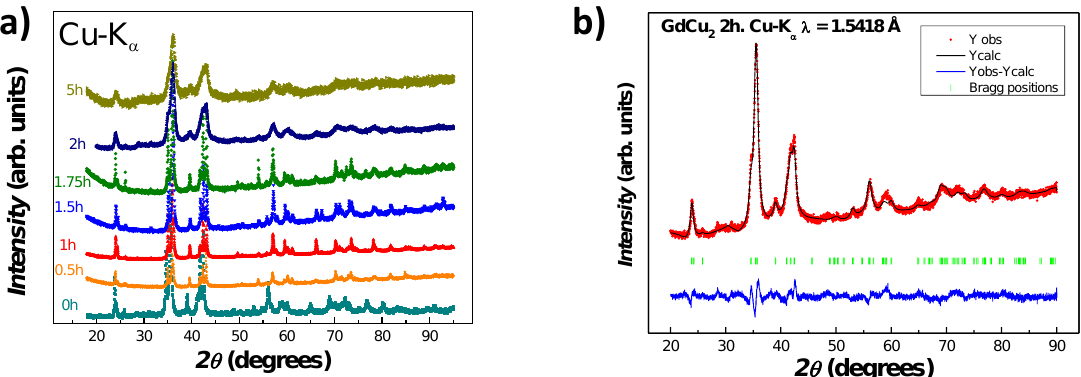
Figure 1. ( a ) XRD profile for GdCu 2 samples. Patterns with increasing milling time have been shifted up and re-scaled for clarity. ( b ) XRD pattern (red), Rietveld refinement (black) and Bragg positions for the hkl peaks (green) obtained for GdCu 2 2h milled NPs. The blue line below the spectrum represents the difference between the experimental and the calculated